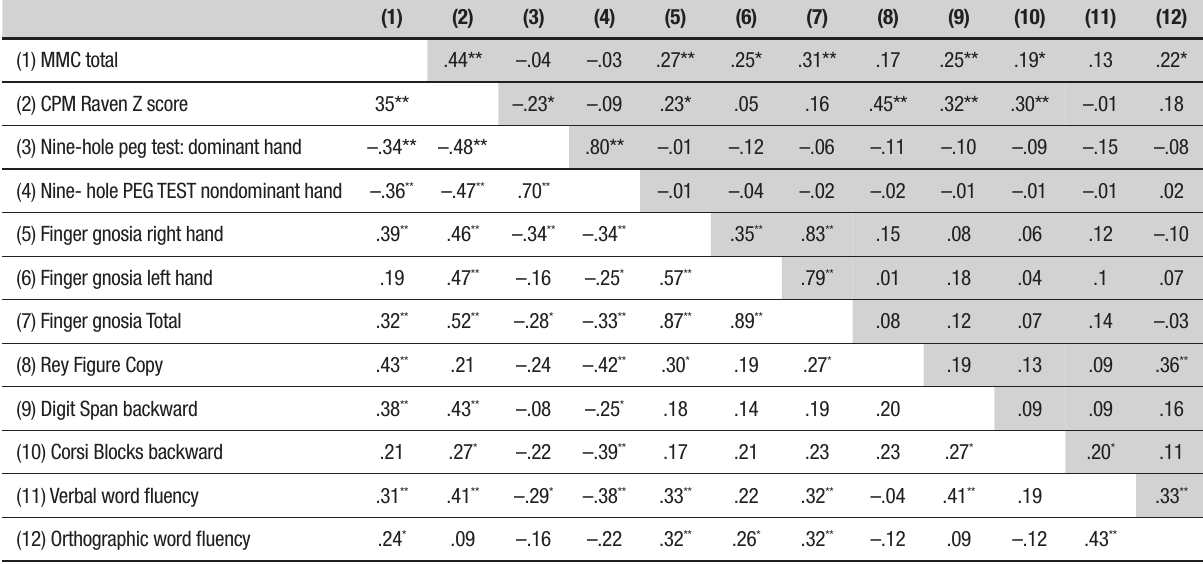
Table 4. Correlation analysis between MMC and neuropsychological tasks according to school